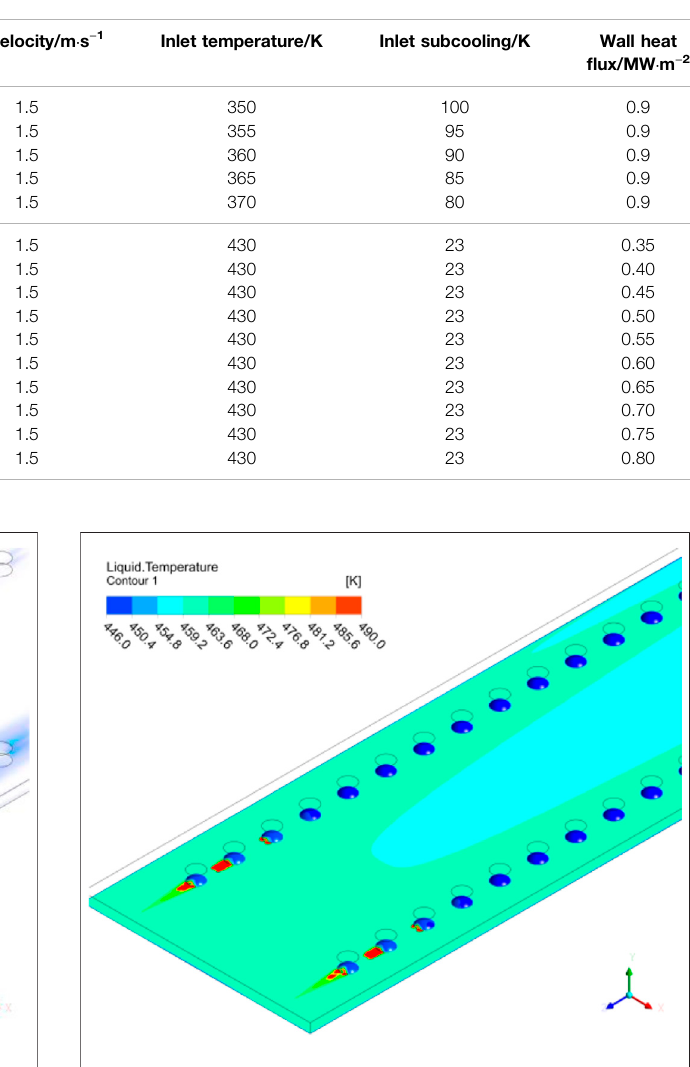
FIGURE 6 | Temperature of cladding for case